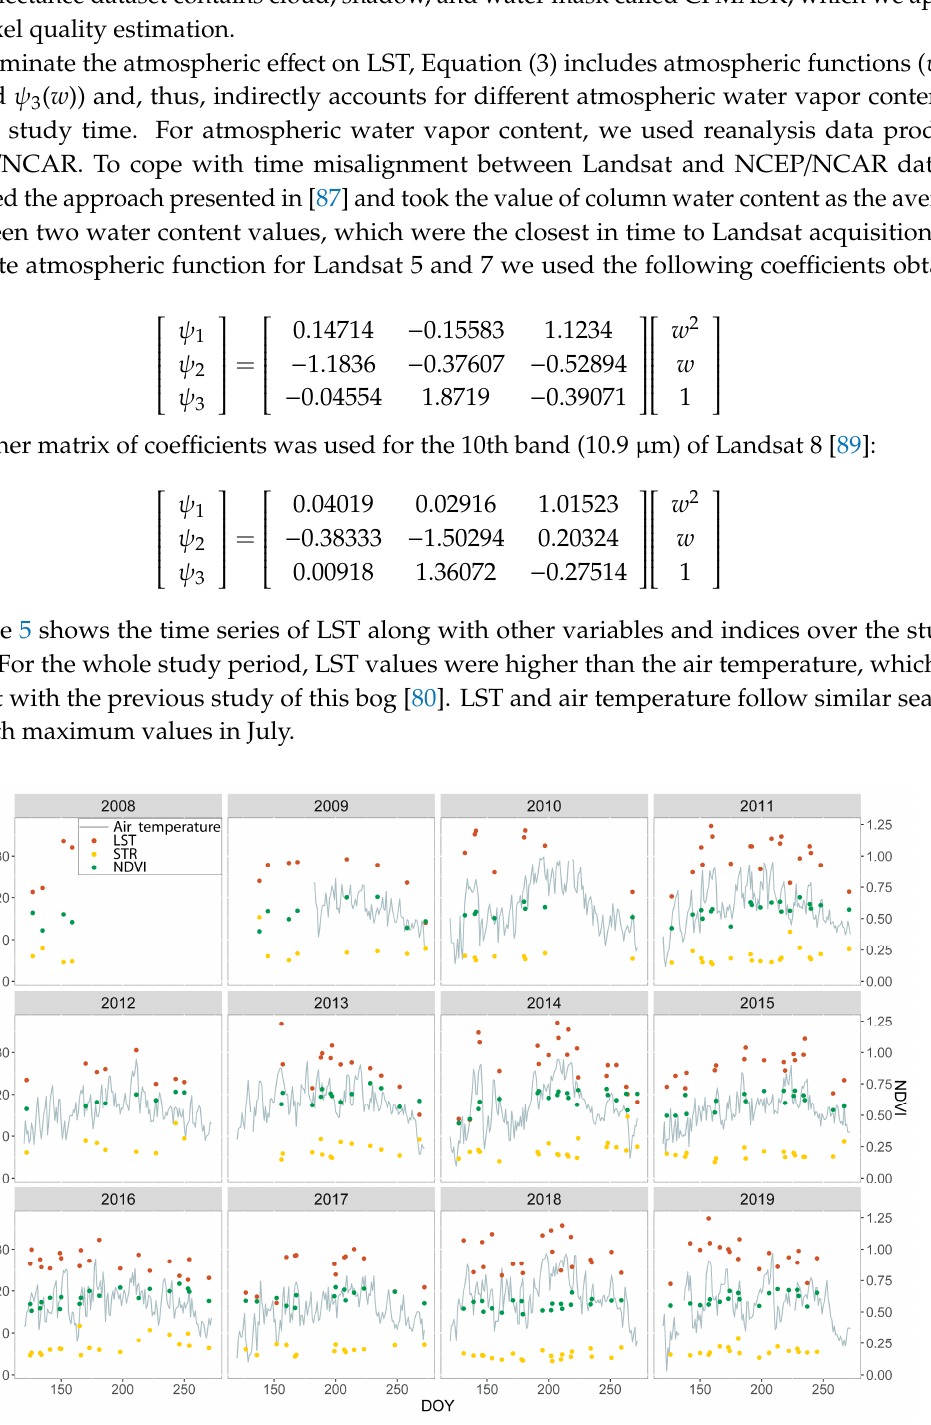
Figure 5. Time series of daily air temperature measured at 9 am UTC (12 am local time) at the weather station, and LST, STR, and NDVI as median values over the Linnusaare and Männikjärve bogs. The gaps in the air temperature line mark missing data due to the technical problems.